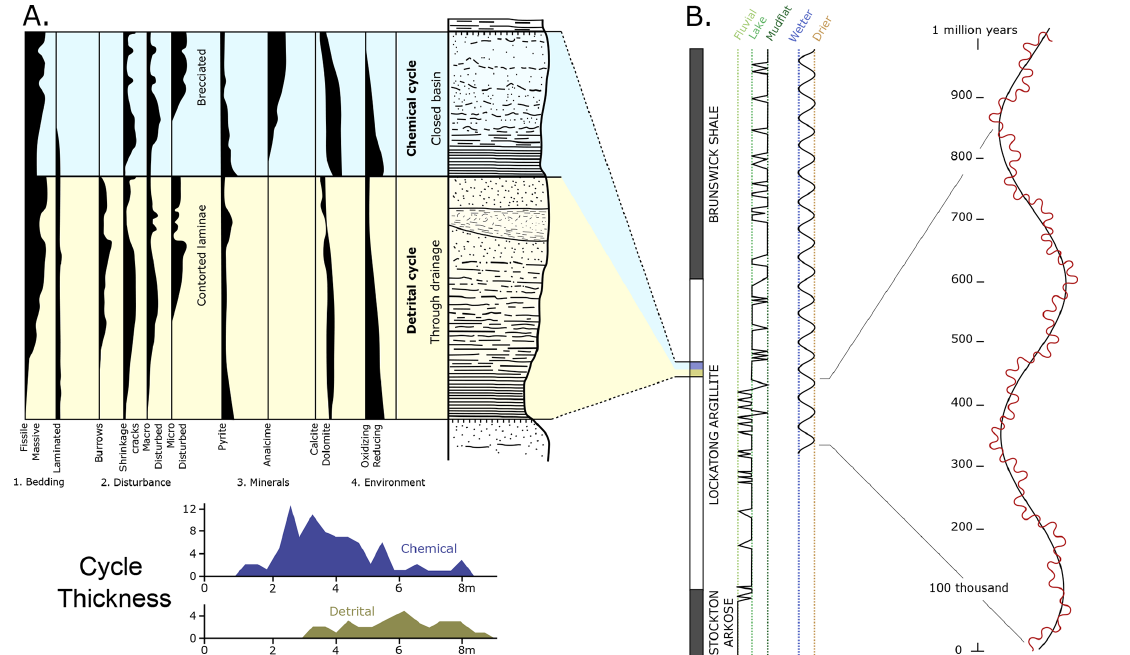
Figure 28. Cyclic lacustrine sedimentation of the Upper Triassic Lockatong Formation (modified from Van Houten, 1964). (a) Model of detrital and chemical short cycles; (b) generalized stratigraphic section of Lockatong Formation and adjacent units. The columns show the alternating geographic environments and the long climatic cycles of wetter and drier phases. An age model is presented based on two long climatic cycles, with intermediate and short cycles